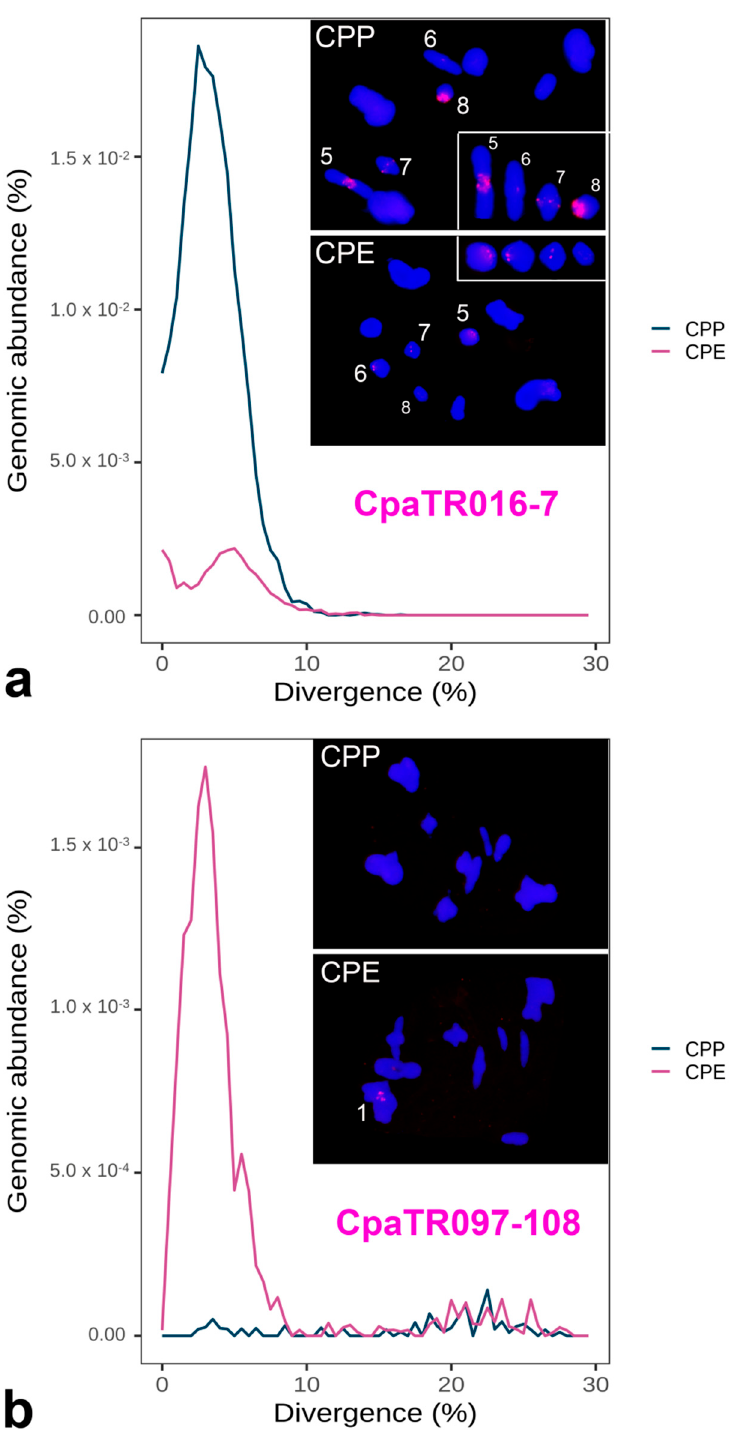
Figure 5. Combined repeat landscapes (RLs) and FISH patterns for two TR families showing higher amplification in one subspecies, as inferred from its higher RL peak paralleled by larger FISH bands, with CpaTR016-7 showing higher amplification in CPP ( a ) and CpaTR097-108 in CPE ( b ). The insets in ( a ) display the four chromosomes showing FISH bands for CpaTR016-7 in one or both subspecies (see also Tables 2 and 3). Bar = 5 μ m.